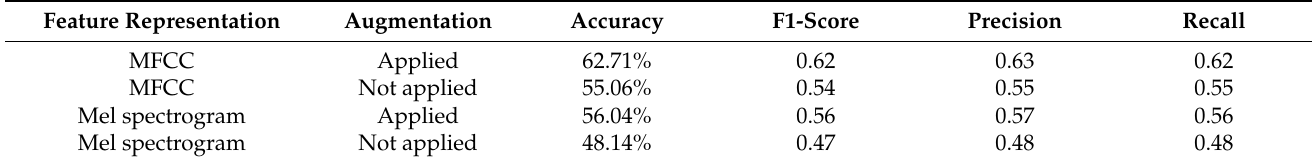
Table 5. Results of ML-based classification of the FSC22 dataset.